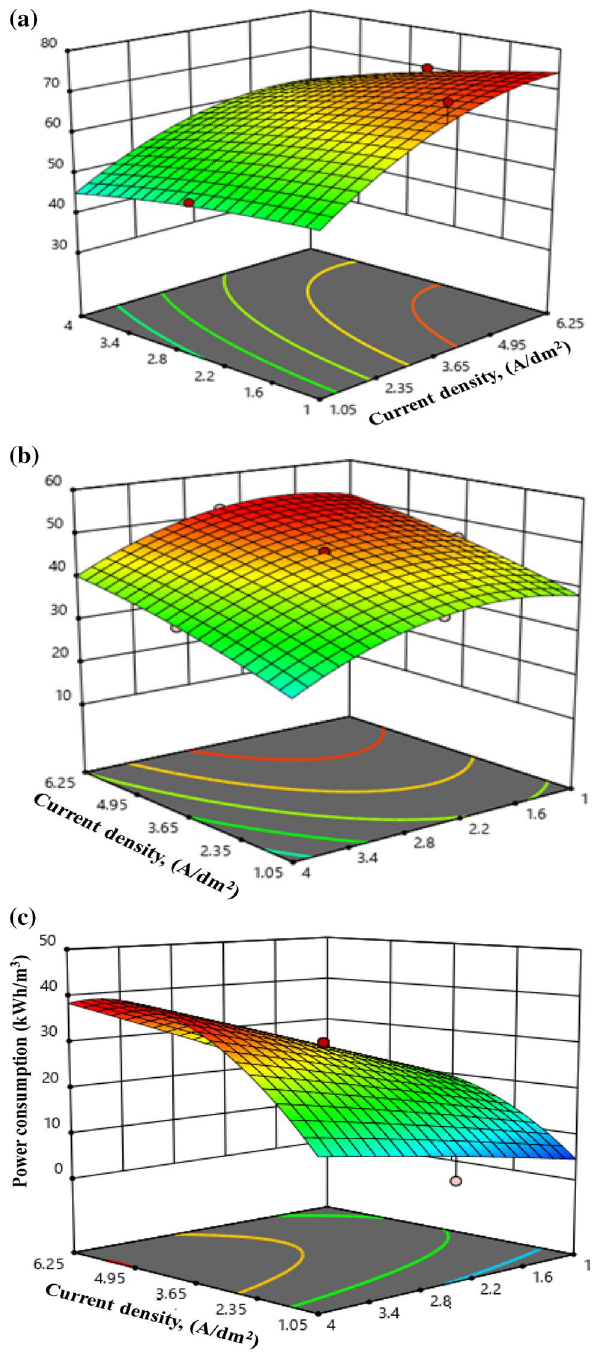
Fig. 3 Combined effect of current density ( X distance ( X 2 ) on a % color removal, b % TOC removal and c power